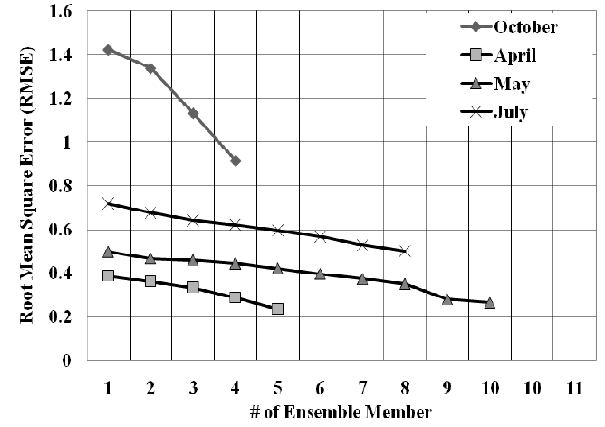
Fig. (14). The Effect of Increasing Number of Ensemble Networks on Root Mean Square Error (RMSE) For Last 10 Percent of the training data set for Month October, April, May and July during the period between 1871 and 1930.